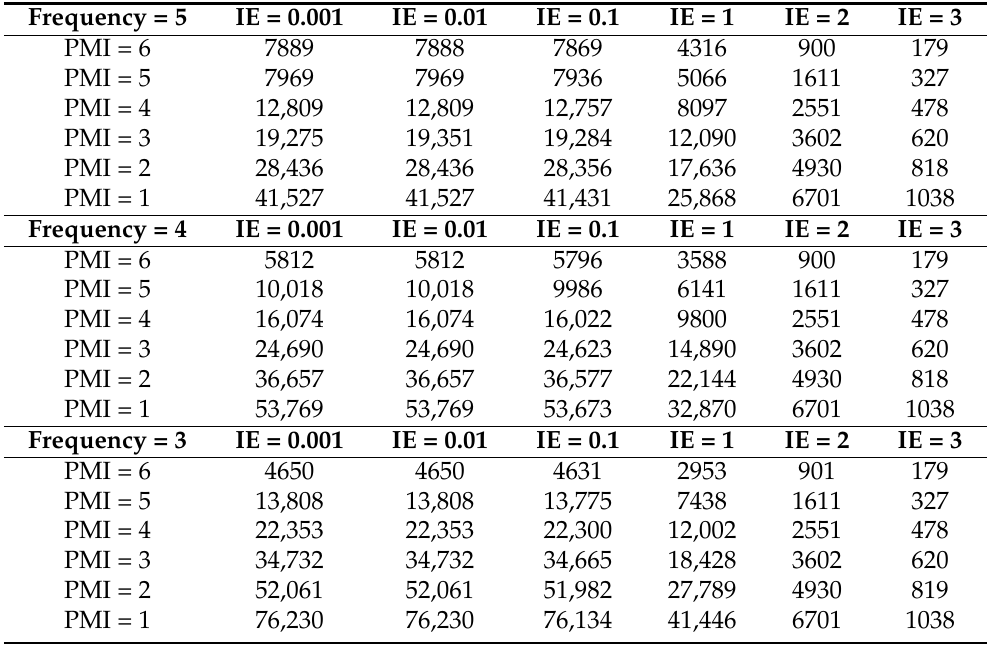
Table 4. The BNShCN probability detection results.